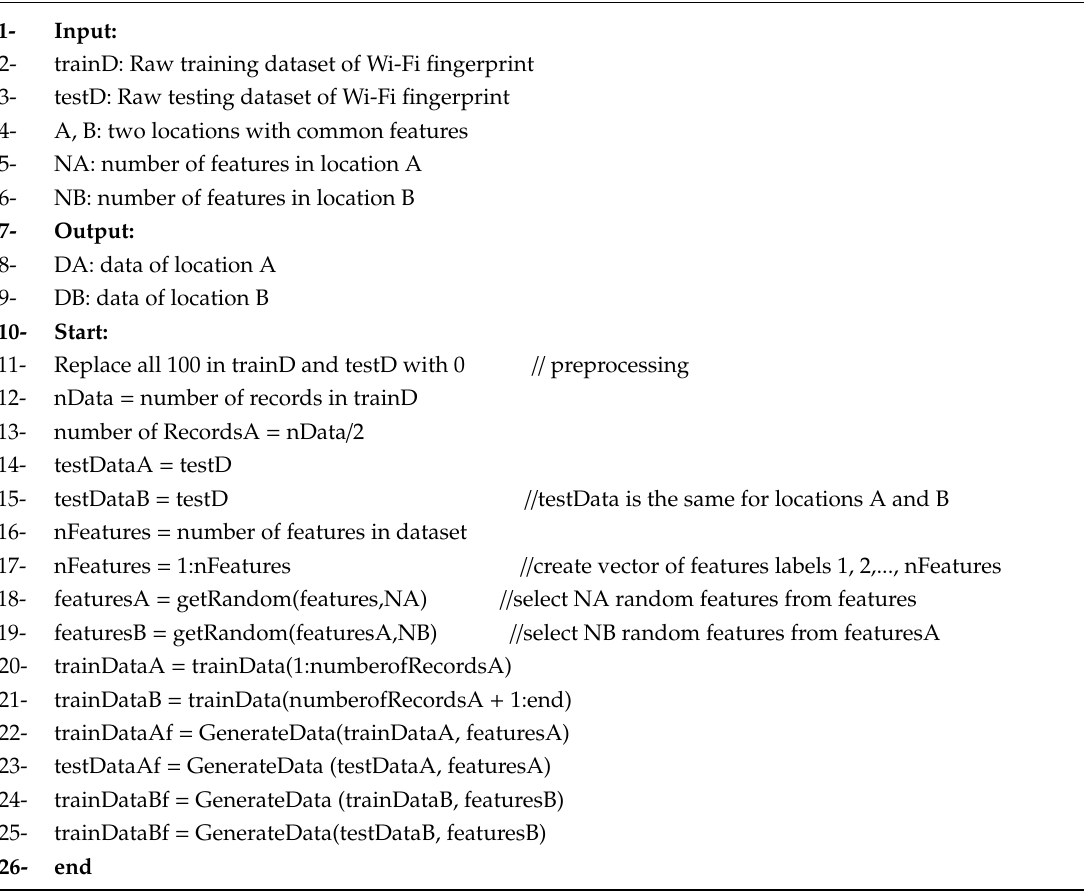
Figure 4. Mesh representation of the relationship between the accuracy, the number of neurons L, and the regularization parameter C for the extreme learning machine (ELM) classifier based on the TampereU dataset. Algorithm 2. Pseudocode for the dataset preparation for testing scenario 1.